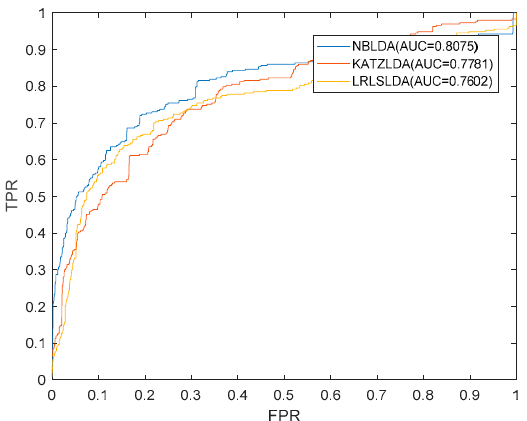
Figure 2. AUCs achieved by NBLDA, KATZLDA, and LRLSLDA based on the dataset of DS 3 .